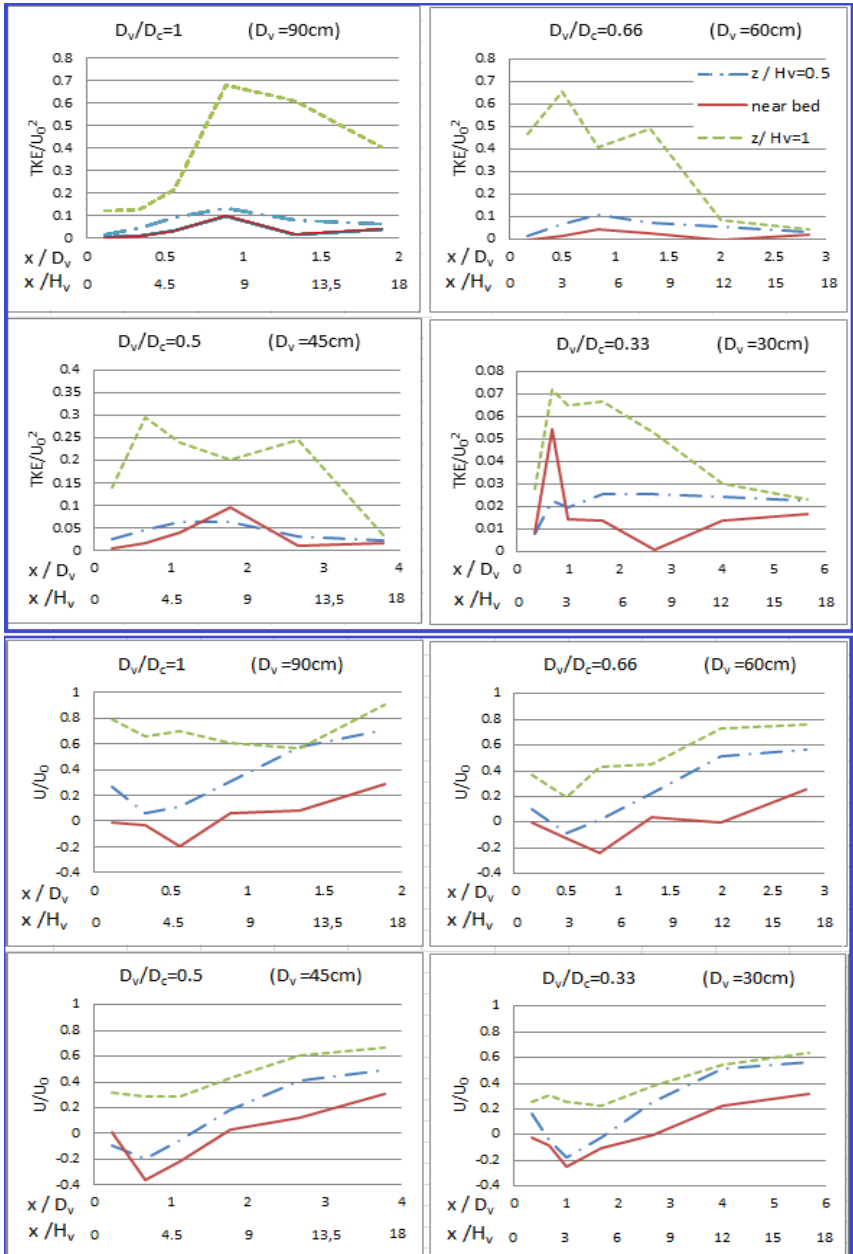
Figure 4. Normalized TKE and streamwise velocity behind 4 different patch layouts near channel bed (z/H v = 0), at the middle height of patch (z/H v = 0.5) and top of patch (z/H v = 1). For experiment cases 2, 3 and 4, there is a shift in the minimum of velocity towards the flow direction. However, since D V /D C is relatively high for case 2 (90 × 60 cm) , the wake behind the vegetation patch ( L vv ) is only shifted in the near-bed region. For cases 3 and 4, the shift of the wake is also detectable at the depths of z/ H V = 0.5 and z/H v = 1. In these cases, the shift of the upper zones exceeds the shift of the near-bed zone. For all four cases, the minimum velocity is negative in the near-bed region, implying a vertical vortex. Considering the values of the corresponding velocities in the upper zone, it is observed that the center of the vortex (or rotation) moves upward if D V /D C decreases. In case 1, the center of the vortex is definitely between the near-bed region and z/ H V = 0.5, while it is located between z/ H V = 0.5 and z/ H V = 1 in case 4 (smallest vegetation patch). This higher center of rotation in case 4 (smallest vegetation patch) pushes down the